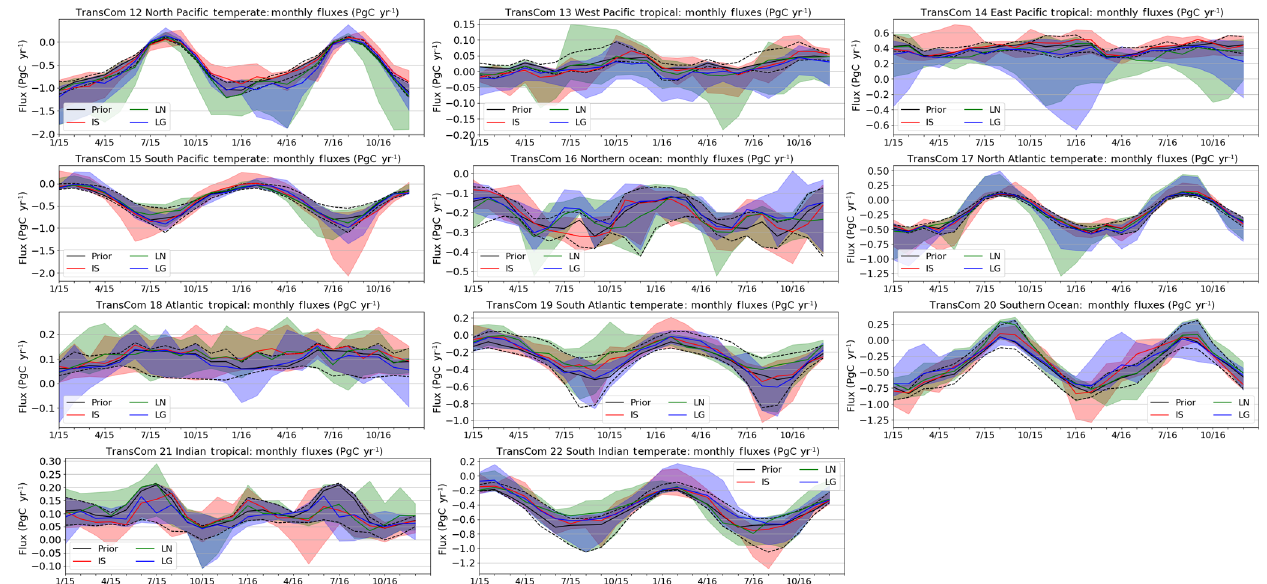
Figure B4. As in Fig. B3, but for the 11 Transcom ocean